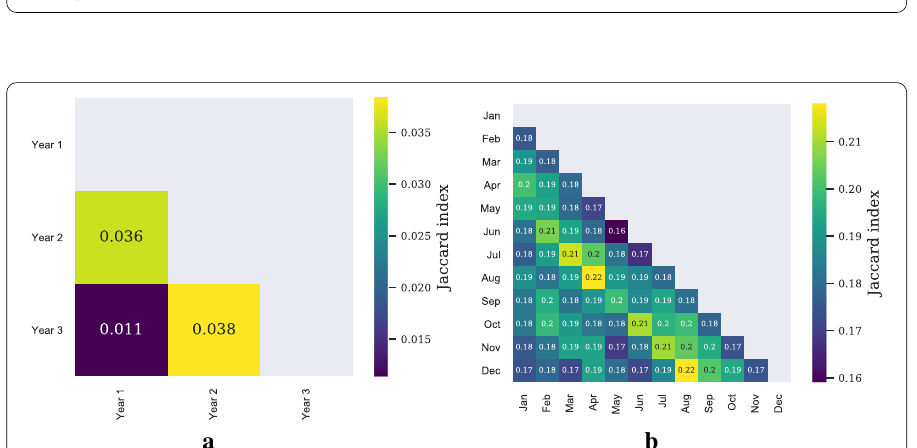
Fig. 4 Training and testing on different periods (Example 1). a Relative penalty reduction for the DL objective and different training periods. Testing is always done in year 3 (Y3). For example, the blue curve indicates the detection performance when node selection was done based on the network of year 1 (Y1). The dashed curve represents detection performance of the degree heuristic. b Relative penalty reduction for the DT objective and different training periods. c Relative penalty reduction for the PA objective and different training periods